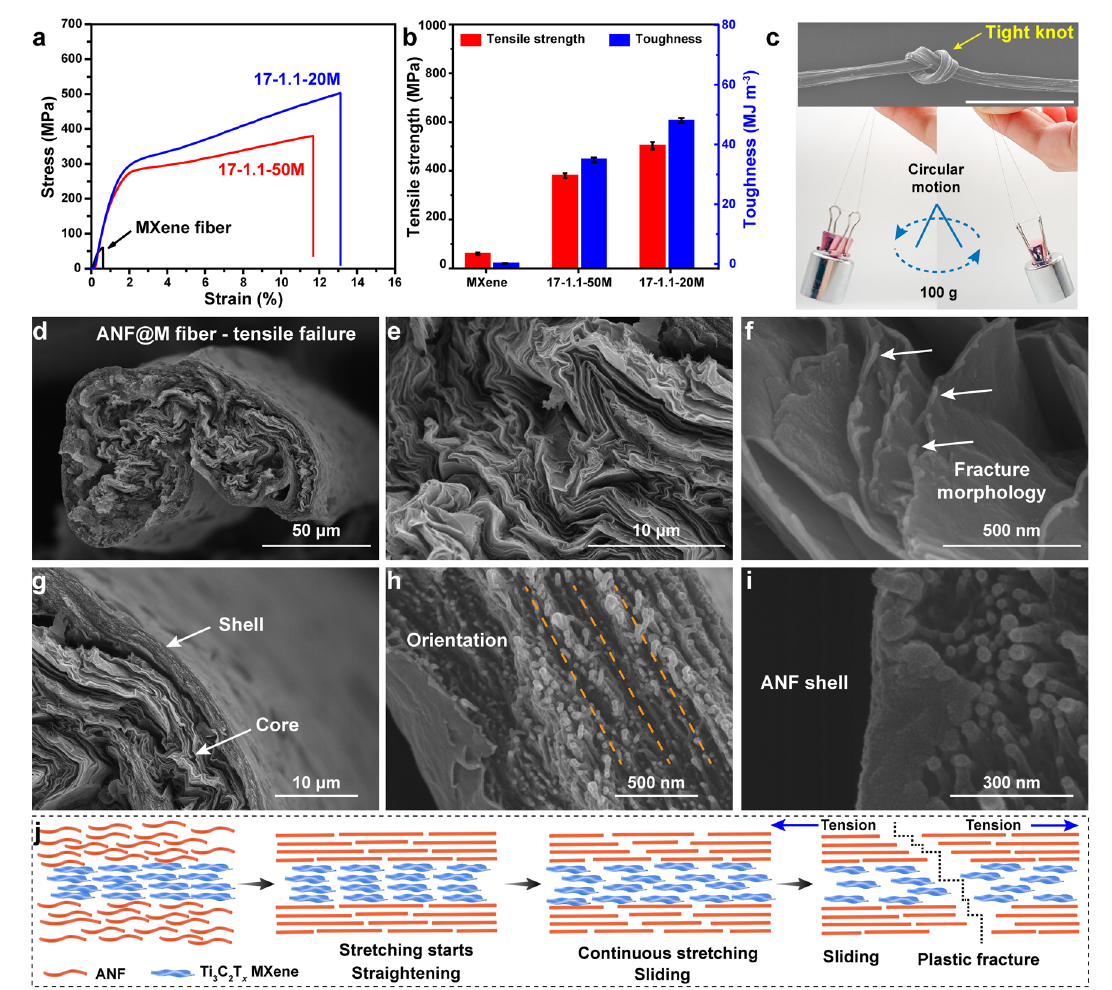
Fig. 2 a Typical tensile stress–strain curves and b comparison of tensile strength and toughness of neat MXene fiber and ANF@M fibers. c SEM image of ANF@M fiber with a tight knot. An ANF@M fiber can support a weight of 100 g for circular motion. The scale bar is 1 mm. Cross section SEM images of d, g overall fracture surface, e, f MXene core, and h, i ANF shell of an ANF@M fiber. j Proposed fracture process of ANF@M